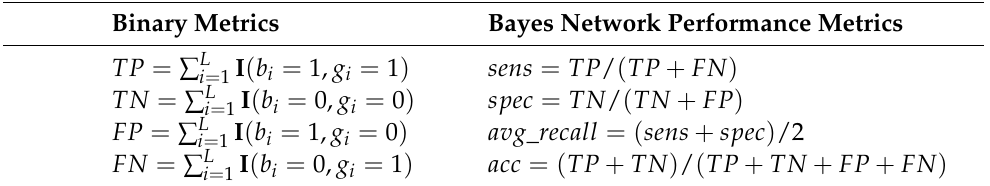
Table 5. Binary metrics of Bayes vector b with respect to ground truth g ( b and g are boolean link-indicator vectors of a link collection of size L ). From binary metrics, Bayes performance metrics are evaluated: sensitivity ( sens ), specificity ( spec ), average recall ( avg_recall ), and accuracy ( acc